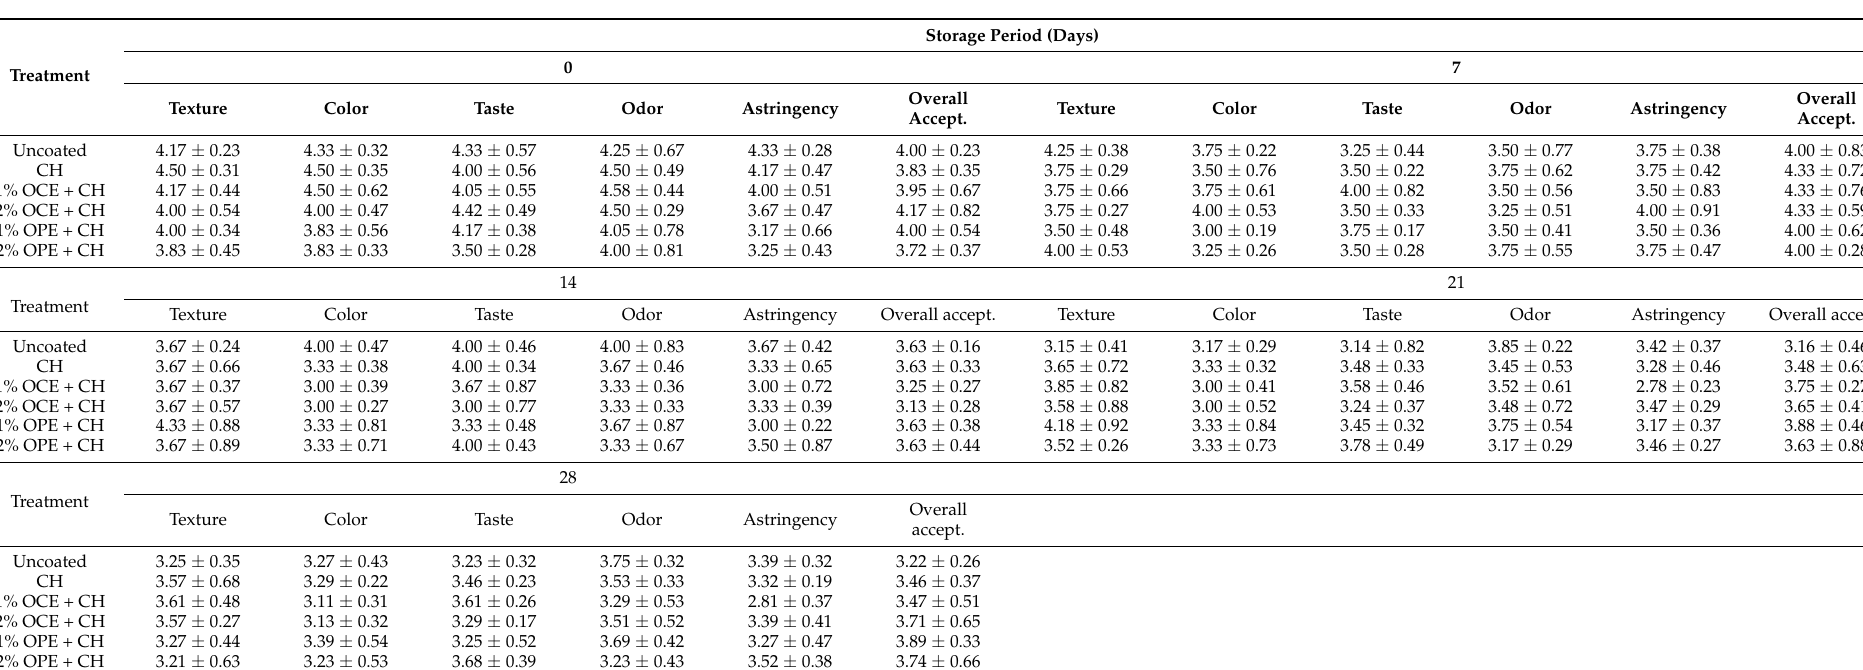
Table 4. Sensory evaluation of fresh Barhi dates coated with chitosan and/or olive cake or orange peel extracts during cold storage (4 ◦